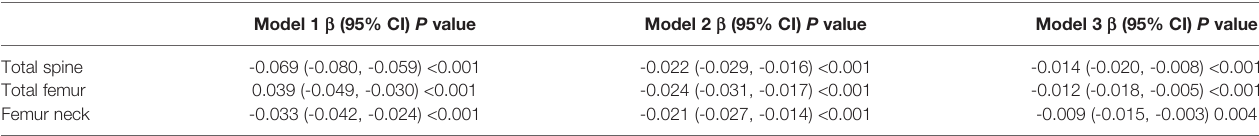
Model1unadjusted.Model2adjustedforage,gender,andrace/ethnicity.Model3adjustedforage,gender,andrace/ethnicity,PIR,bodymassindex,serumcalcium,serumphosphorus. BLL Blood lead levels. BMD bone mineral density. PIR poverty income